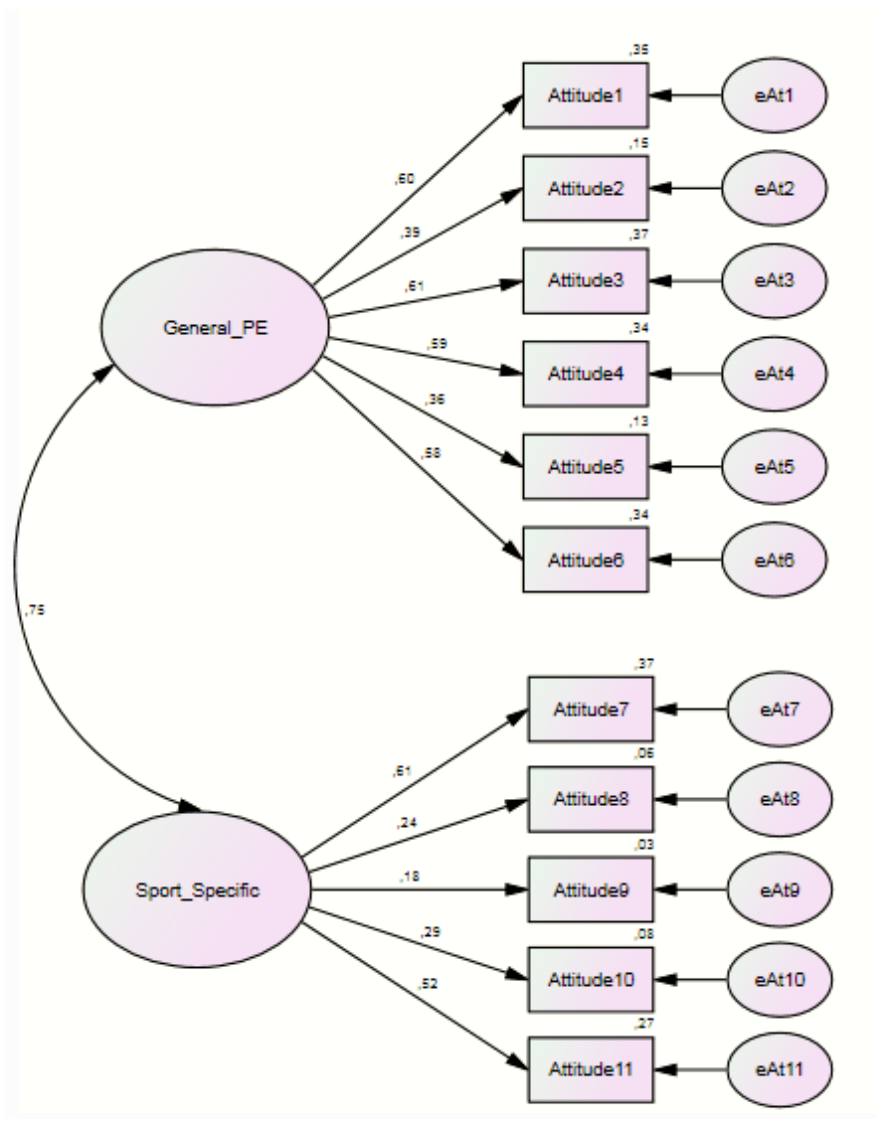
Confirmatory factor analysis of the two factors structure for the CAIPE-R